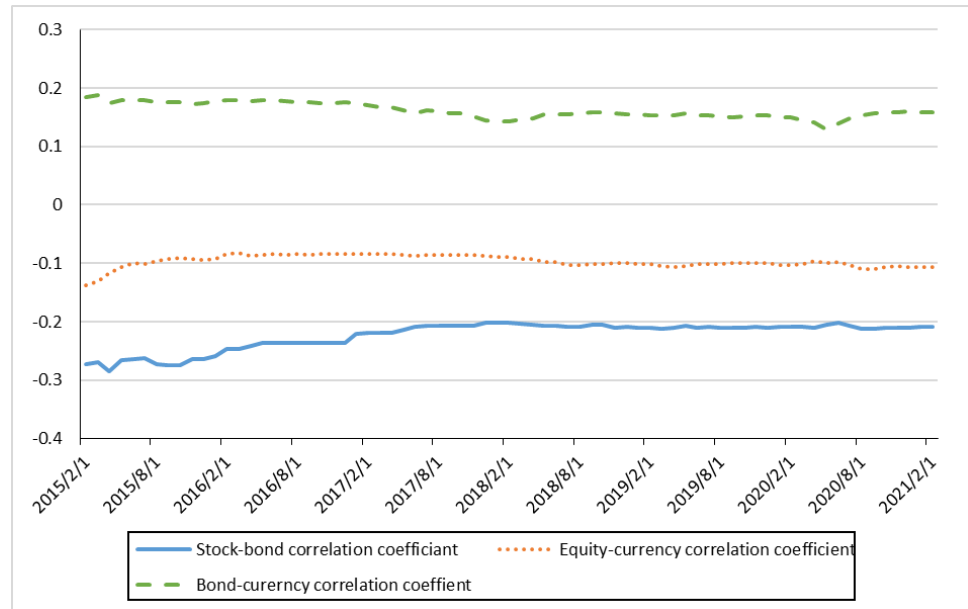
Figure 2. Correlation coefficient changes of the three types of assets.